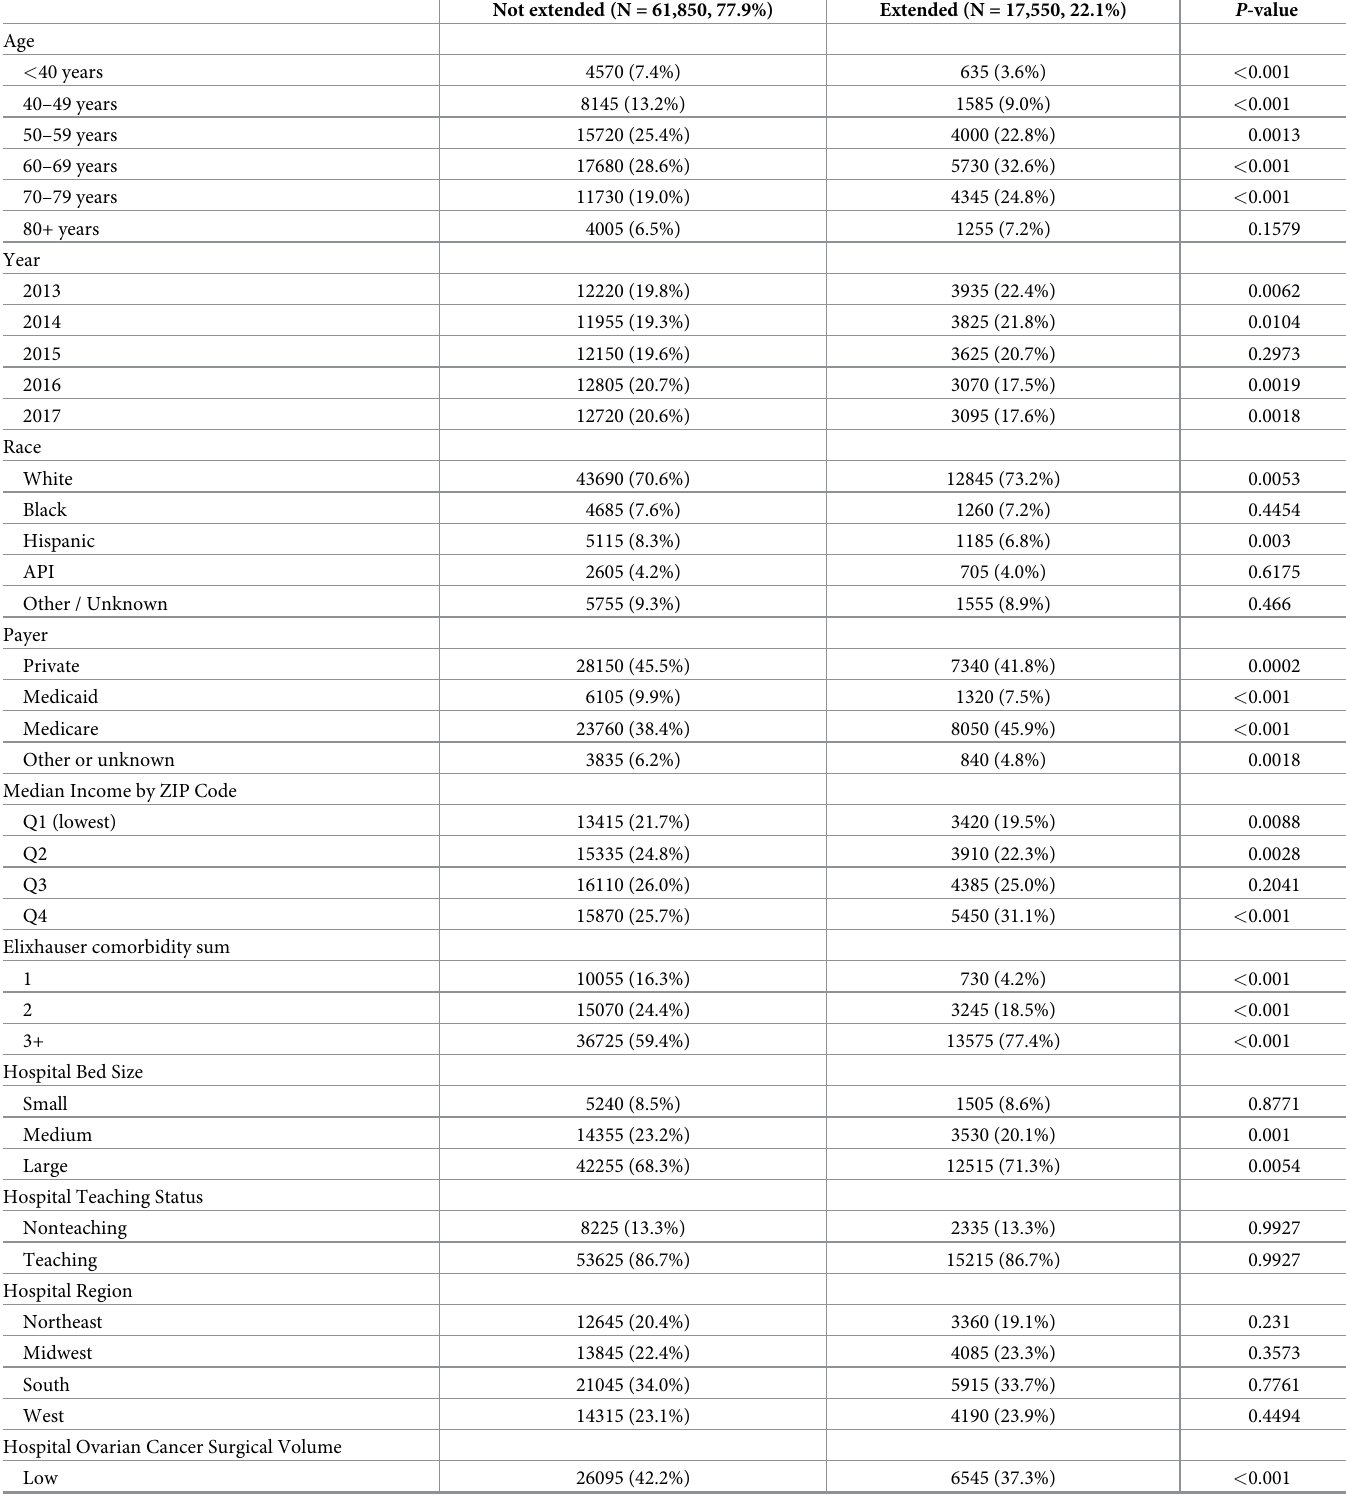
Table 1. Population demographics stratified by occurrence of extended cytoreductive